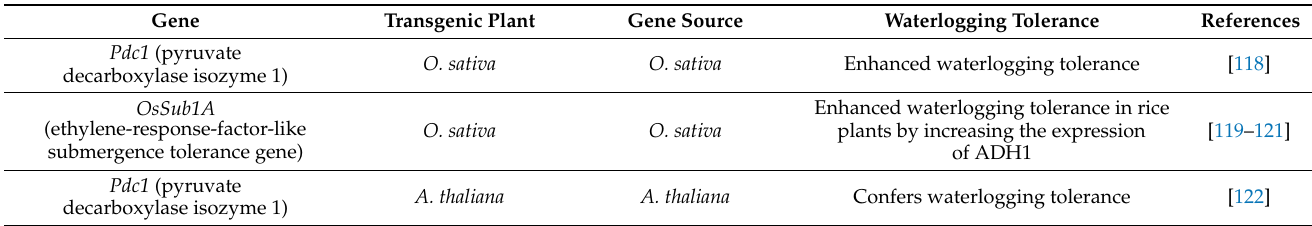
Table 3. The role of genetic engineering in developing waterlogging-tolerant